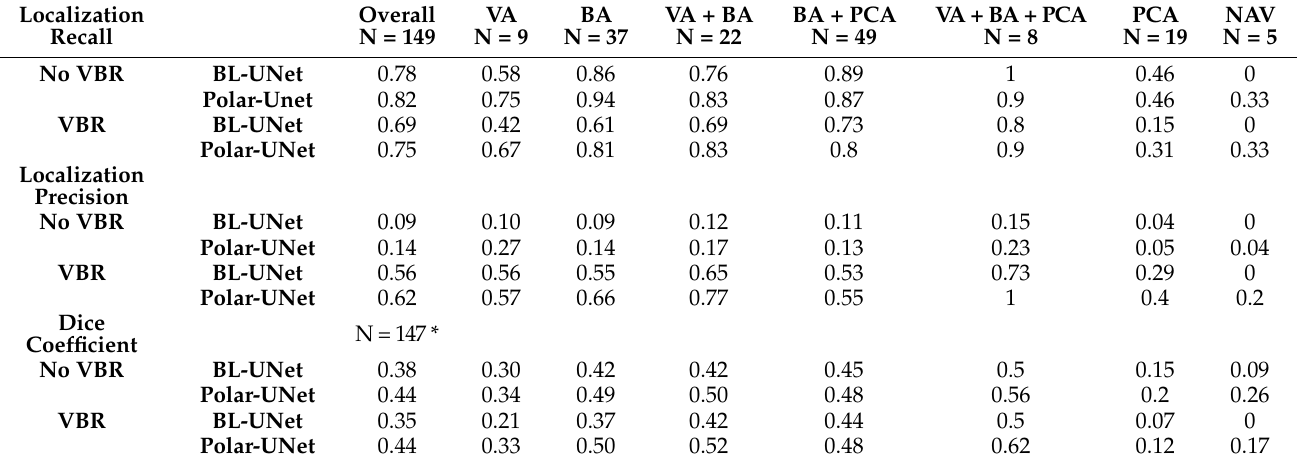
Table 1. Thrombus localization recall and precision in the posterior circulation and the Dice coefficient of the BL-UNet and Polar-UNet, with and without volume-based removal (VBR). Results are shown for the entire dataset (overall), the vertebral artery (VA), basilar artery (BA), posterior cerebral artery (PCA), thrombi which crossed multiple segments (VA + BA, BA + PCA, VA + BA + PCA), and patients for whom the thrombus location was not indicated (NAV). * Two scans did not have a visible thrombus. Hence, the Dice coefficient was calculated for 8 patients with a thrombus in the VA and 4 with an unspecified occlusion location